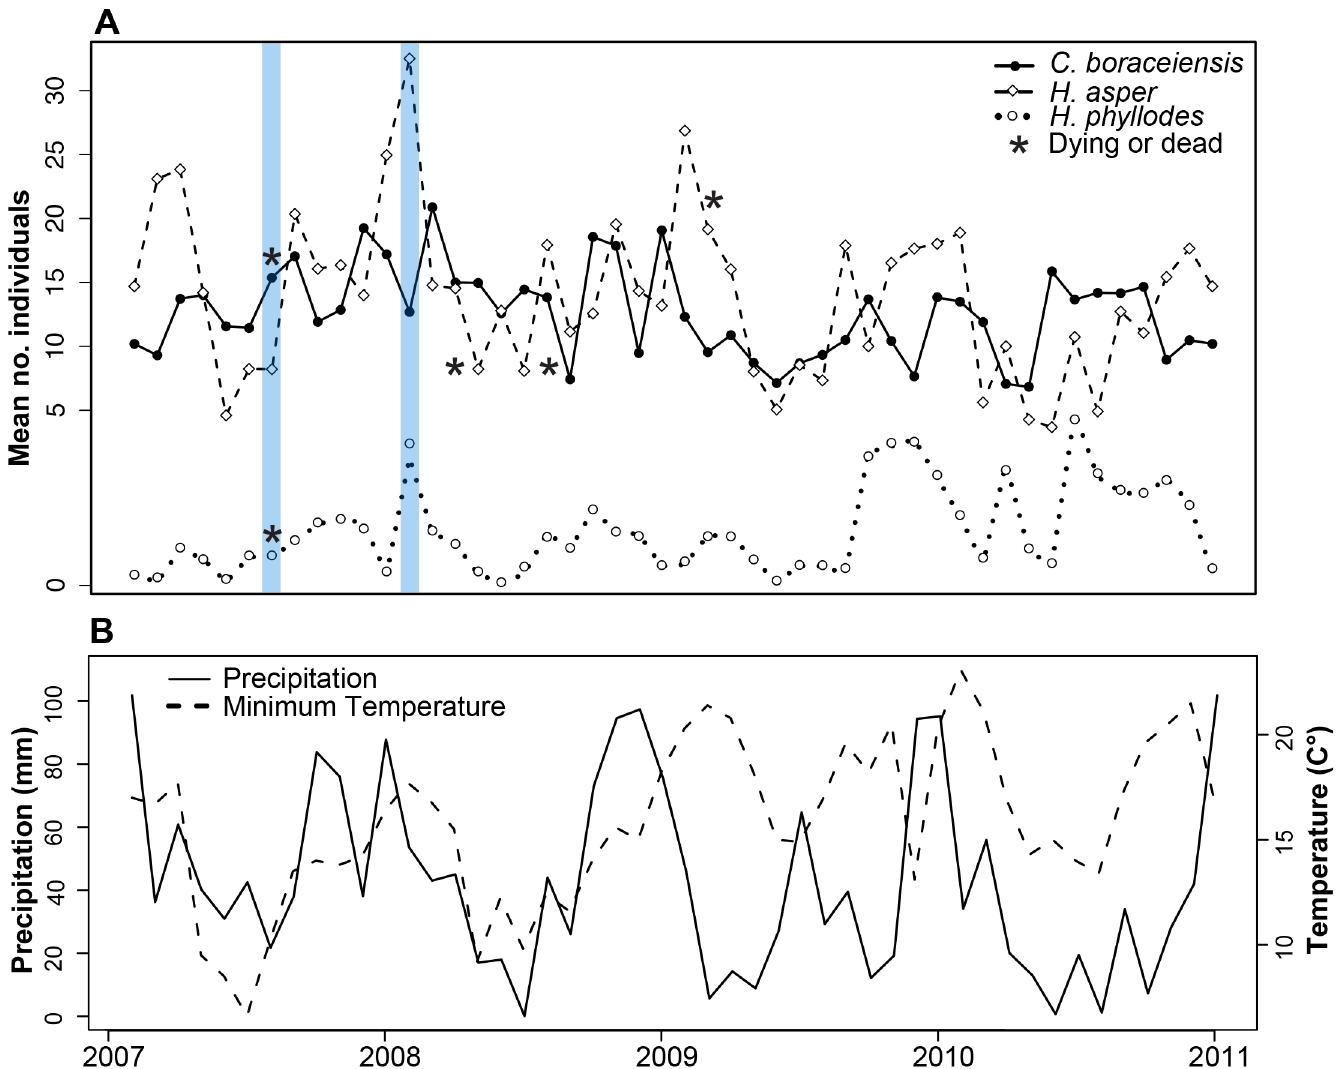
Fig 1. Mean number of individuals, temperature and precipitation. Four-year time series data of: (A) the mean number of individuals found in four stream transects, and (B) monthly minimum temperature (°C) and precipitation (mm) at Parque Estadual da Serra do Mar, Brazil. Shaded bars highlight Batrachochytrium dendrobatidis swab sampling. The first asterisk (dead or dying frog) for C . boraceiensis represents two individuals found within 3 days. Sampling began February 2007 and continued monthly through January 2011.